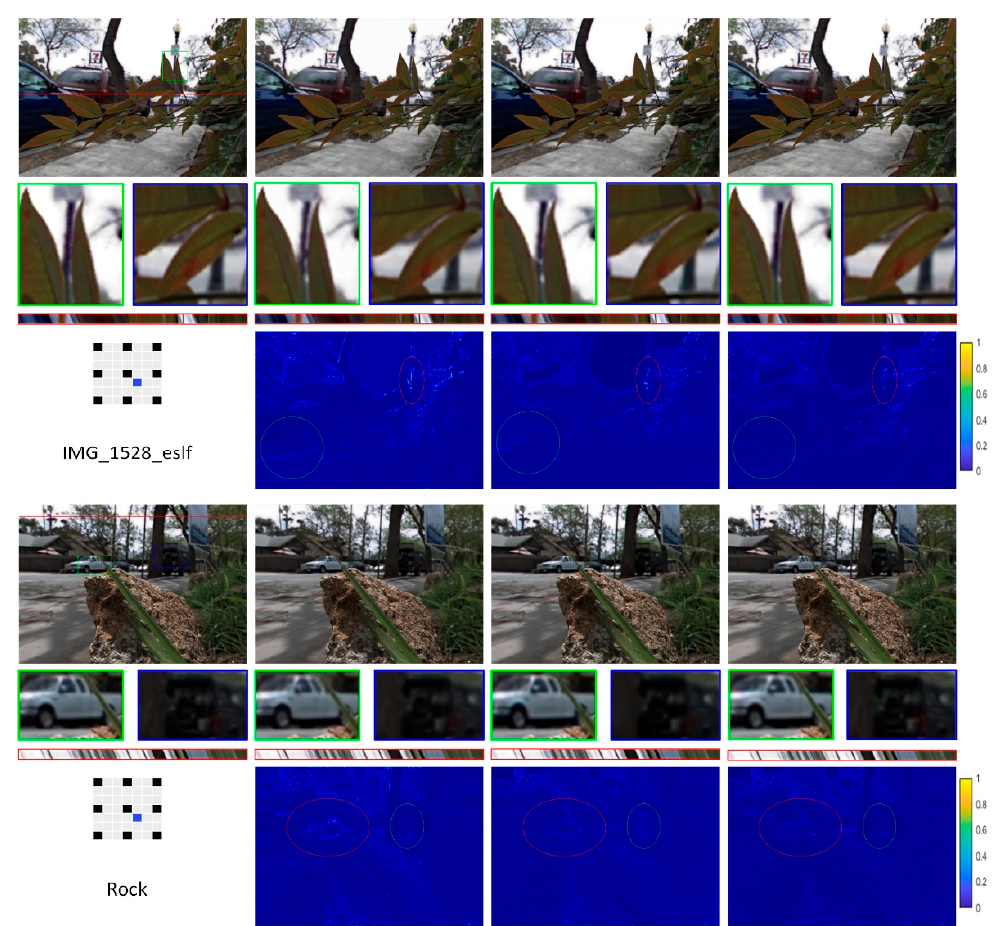
Figure 6. Visual comparison of LF image reconstruction with other methods together with the corresponding ground-truth images. Error maps between reconstructed luminance images and corresponding ground-truth are also shown. On the left side of the error maps, black images represent input views, gray the images to be reconstructed, and blue the displayed view. Extracted EPIs are shown in red boxes in addition to a close-up of image portions in blue and green boxes. Error maps demonstrate the capability of our method. For example, in the Cars scene, the green circle indicates the error around the rear tire of the car.